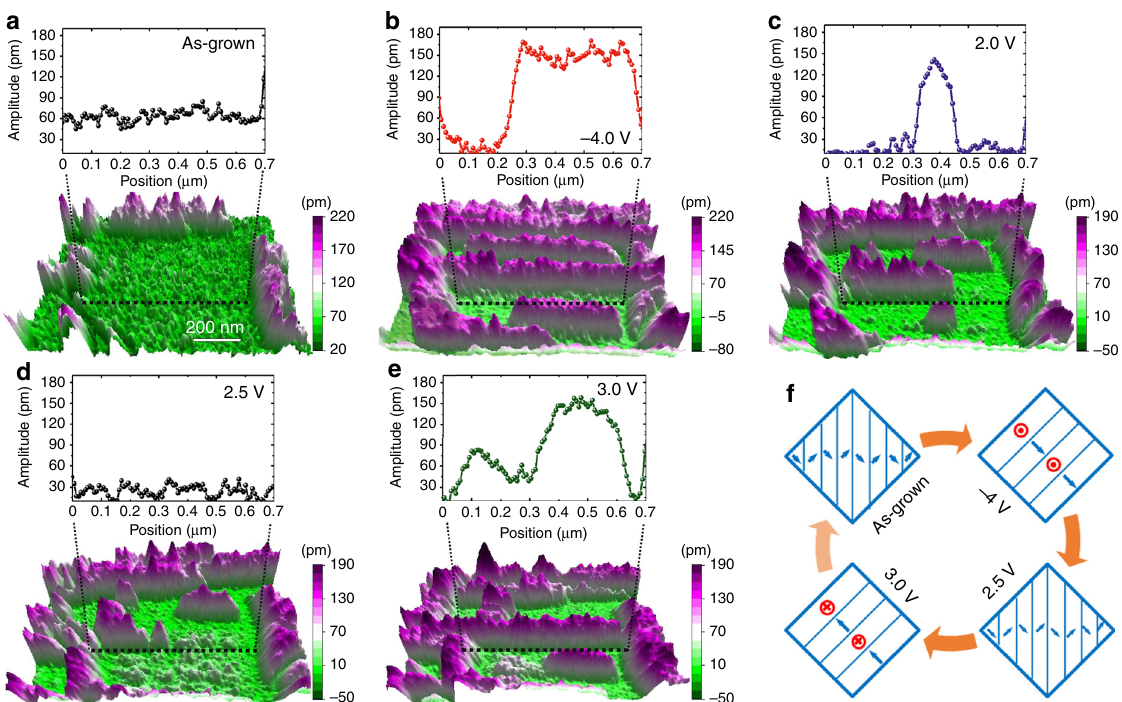
Fig. 2 Ferroelastic switching via out-of-plane electric fi eld poling. 3D representation of the out-of-plane piezoresponse force microscopy (PFM) amplitude and corresponding line trace along the noted dashed lines in ( a ), as-grown state, b after being poled upward via a − 4 V bias, c after an applied + 2 V bias, d after an applied + 2.5 V bias, and e after further increasing bias to + 3 V. f Schematic illustration of the domain-structure evolution under stepwise